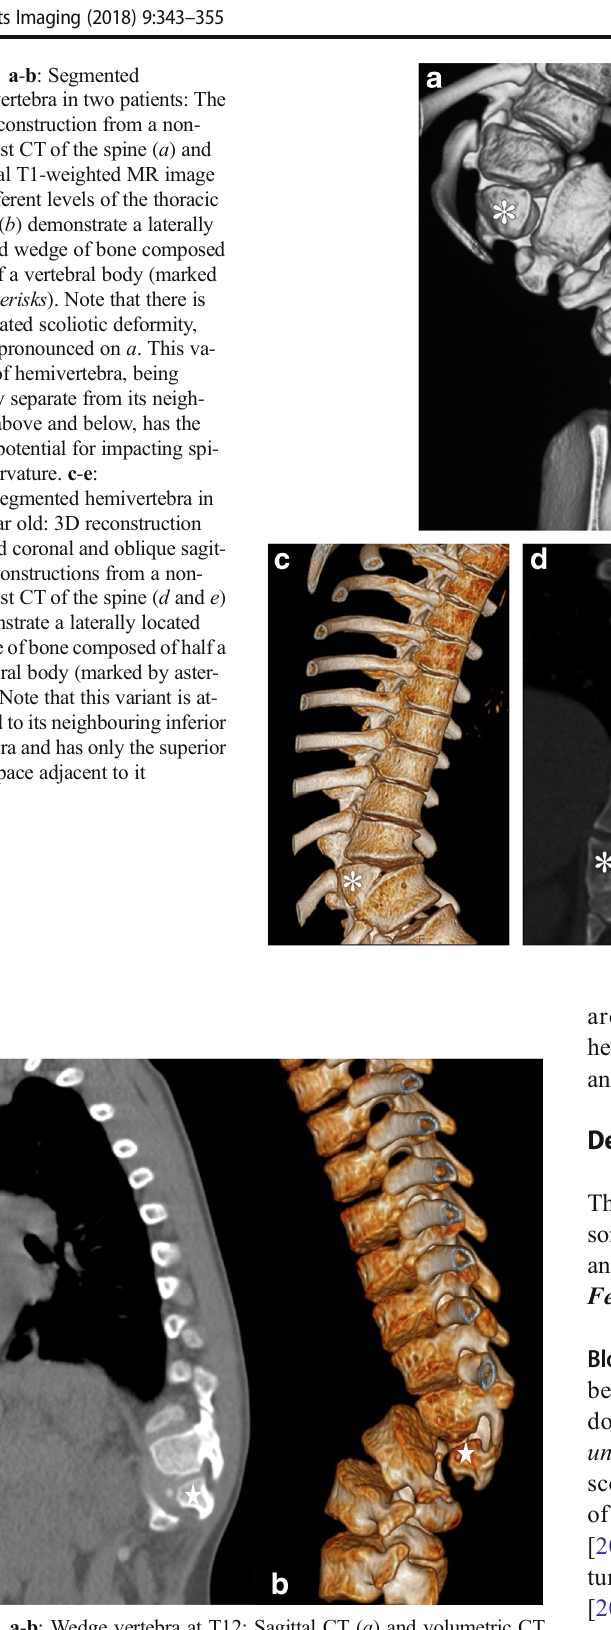
Fig. 9 a - b : Wedge vertebra at T12: Sagittal CT ( a ) and volumetric CT reconstruction of the spine ( b ) demonstrate a small, wedge-shaped T12 ( stars on a and b ) with associated focal kyphosis; there was associat- ed scoliosis (not